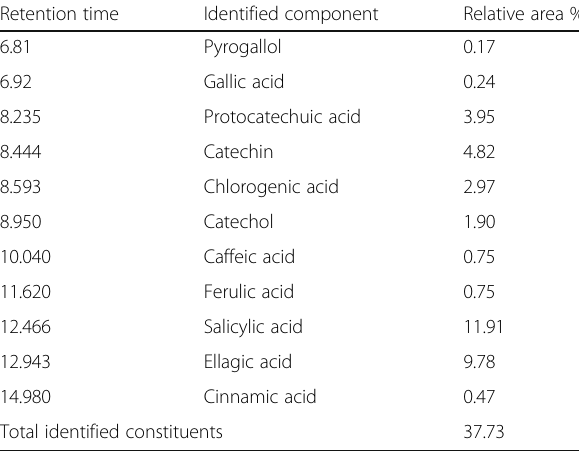
Table 2 RP-HPLC analysis of phenolics components of C. azarolus var. eu- azarolus leaves extract at λ = 280